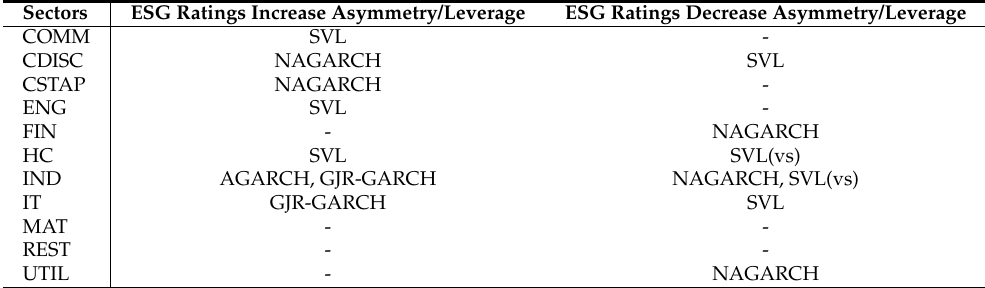
Table 9. Summary of results by sector for the LFD-GLS approach.